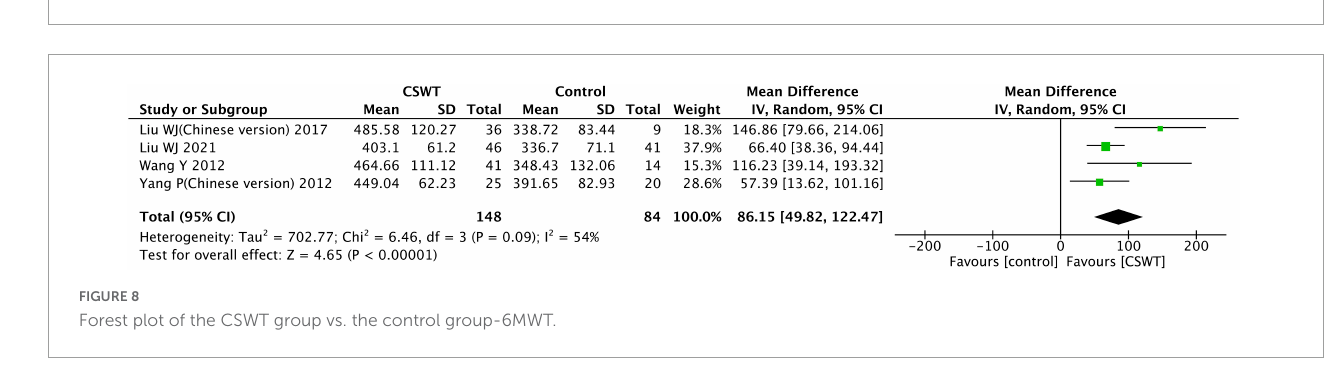
FIGURE7 Forest plot of the CSWT group vs. the control group-NYHA class.